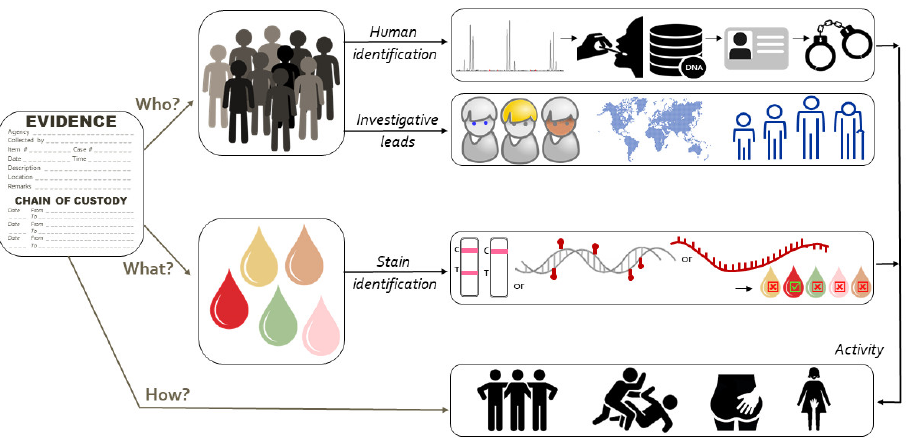
Figure 1. Stain identification in the context of the forensic process showing the link between ‘who’, ‘what’ and ‘what’ and ‘how’.